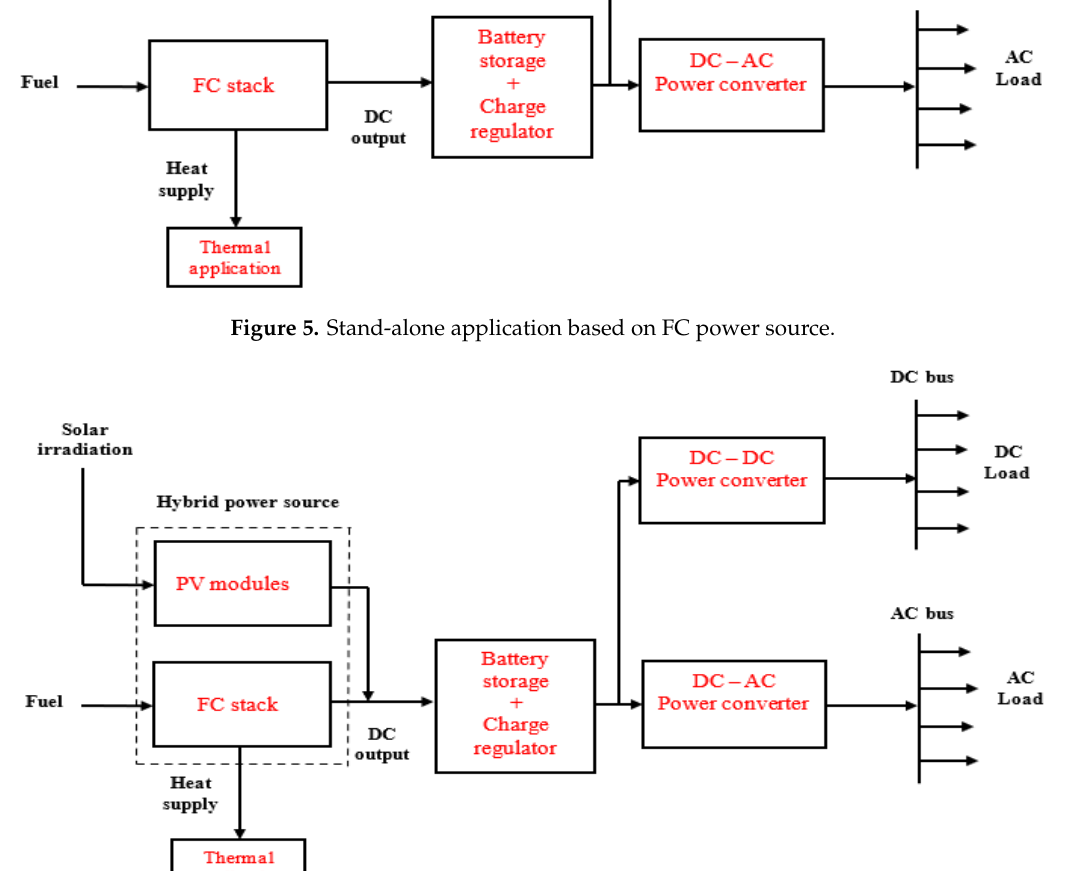
Figure 6. Stand-alone application based on the FC and PV power sources.